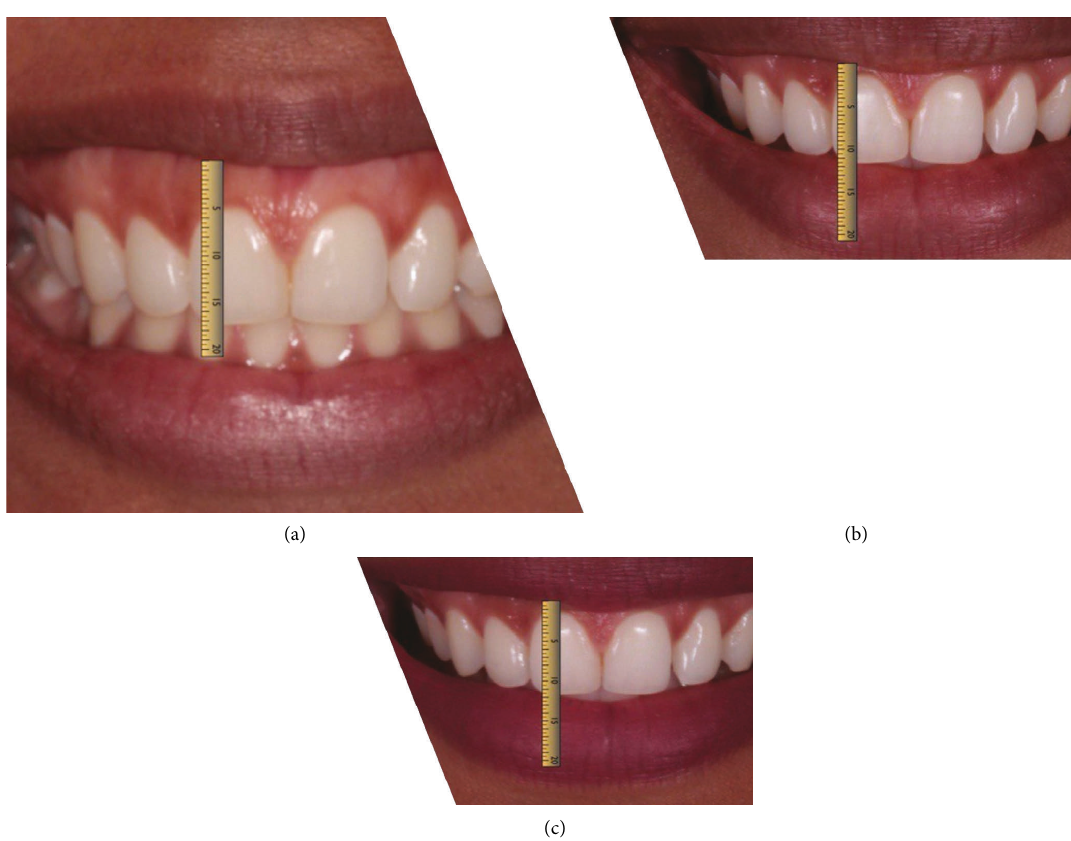
Figure 11: (a) Measurement of an initial smile. (b) 6 months postsurgery. (c) 12 months